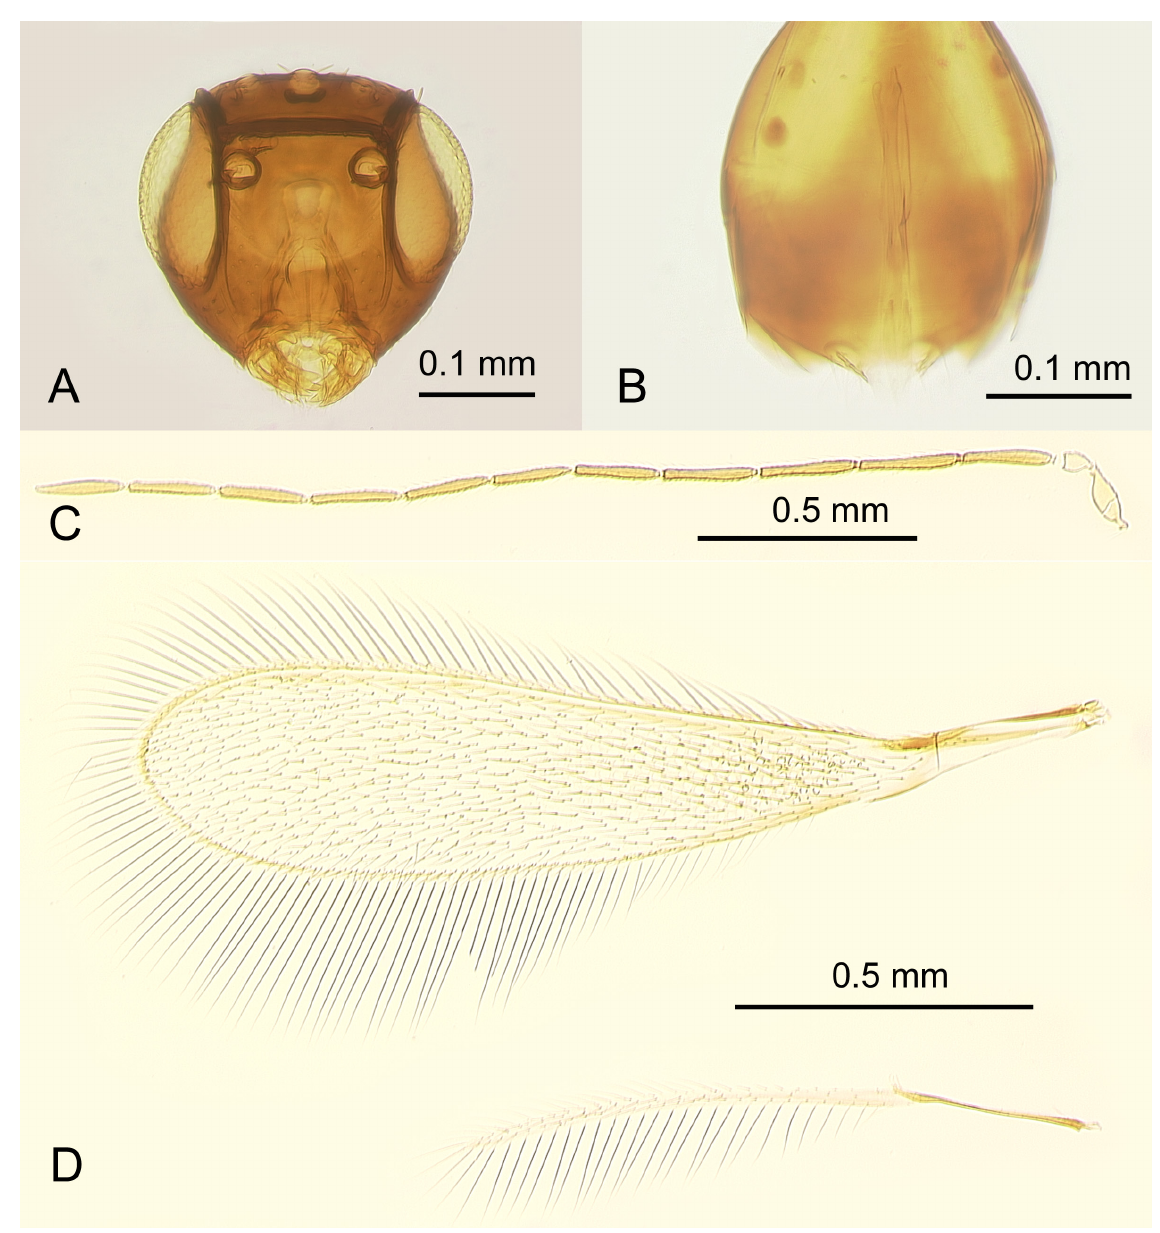
Fig. 5. Ganomymar caslot sp. nov., ♂, paratype (CASENT 2079167). A . Head in frontal view. B . Genitalia. C . Antenna. D . Fore and hind